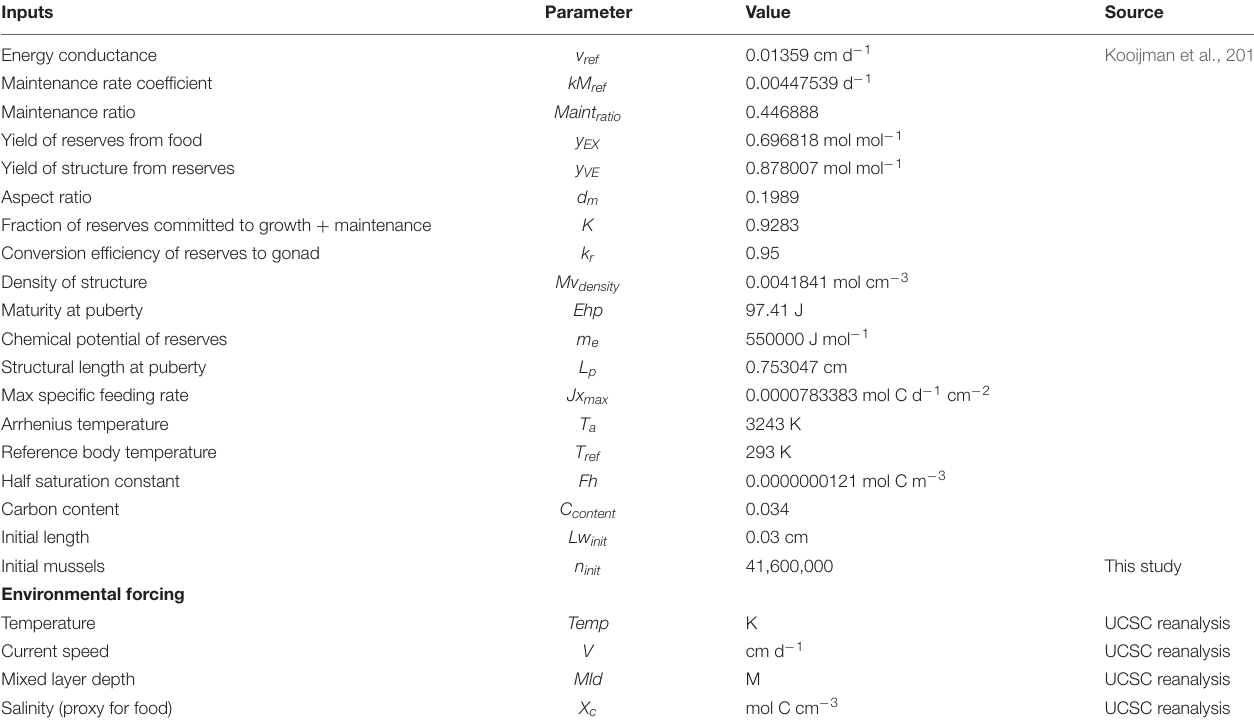
TABLE 1 | Mussel model growth model parameters and environmental forcing